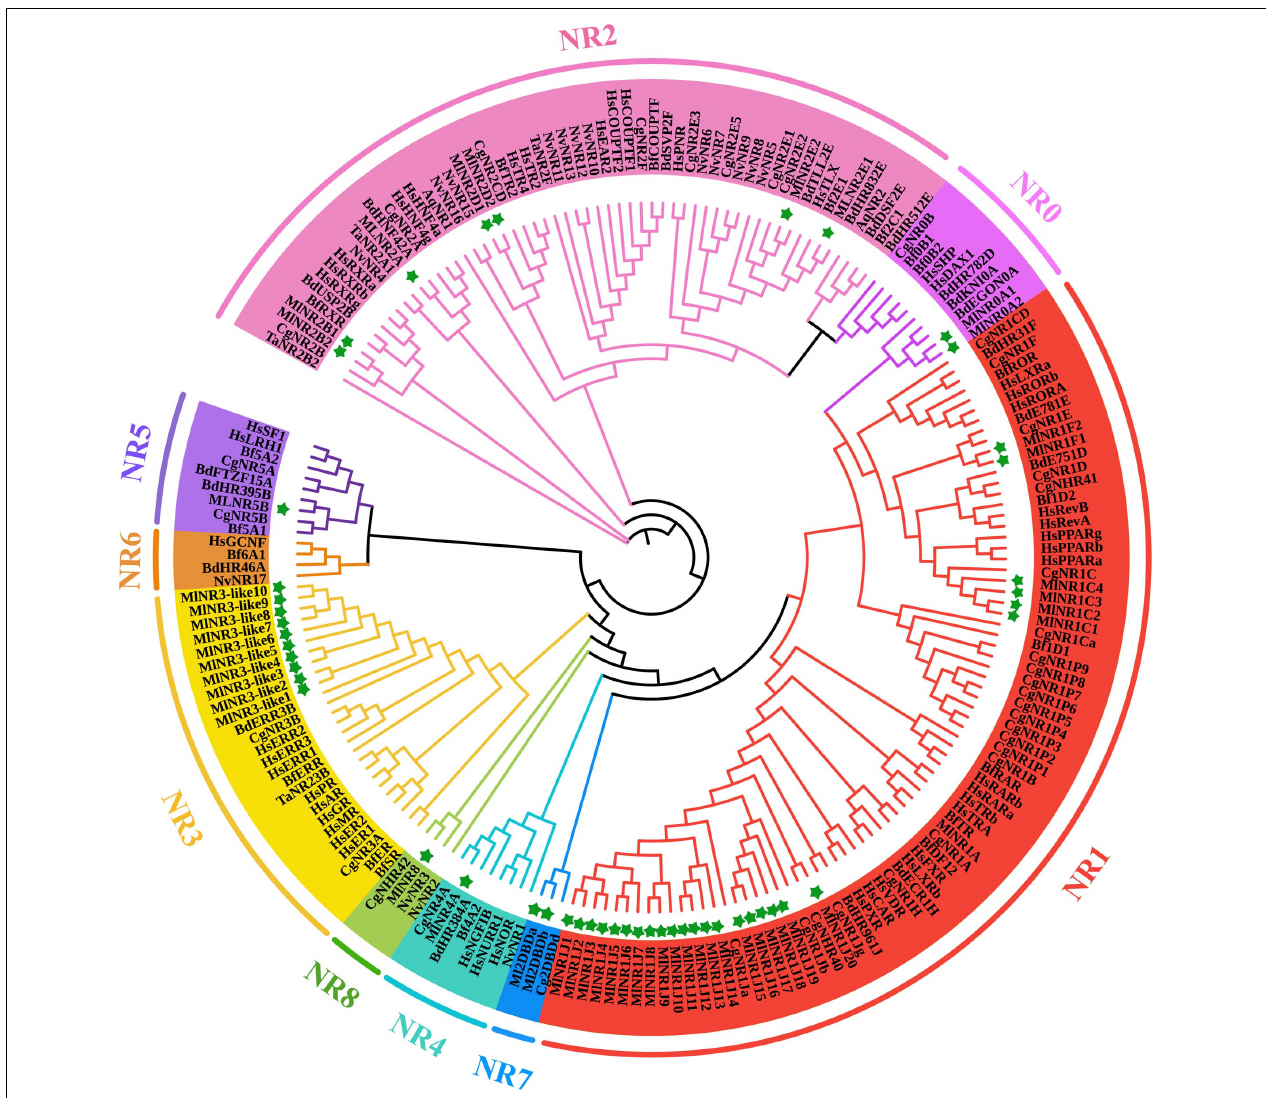
FIGURE 1 | ML phylogenetic tree of NR proteins from M. lignano (Ml), Amphimedon queenslandica (Aq) , Trichoplax adhaeren (Ta) , Nematostella vectensis (Nv) , Crassostrea gigas (Cg) , Bactrocera dorsalis (Bd) , Branchiostoma floridae (Bf), and Homo sapiens (Hs). The ML method was used to construct the unrooted tree by the program IQTREE. The amino acid sequences of the DBD and LBD domains that belong to NR proteins were aligned using the software Bioedit. Green stars indicate the NR proteins from M. lignano